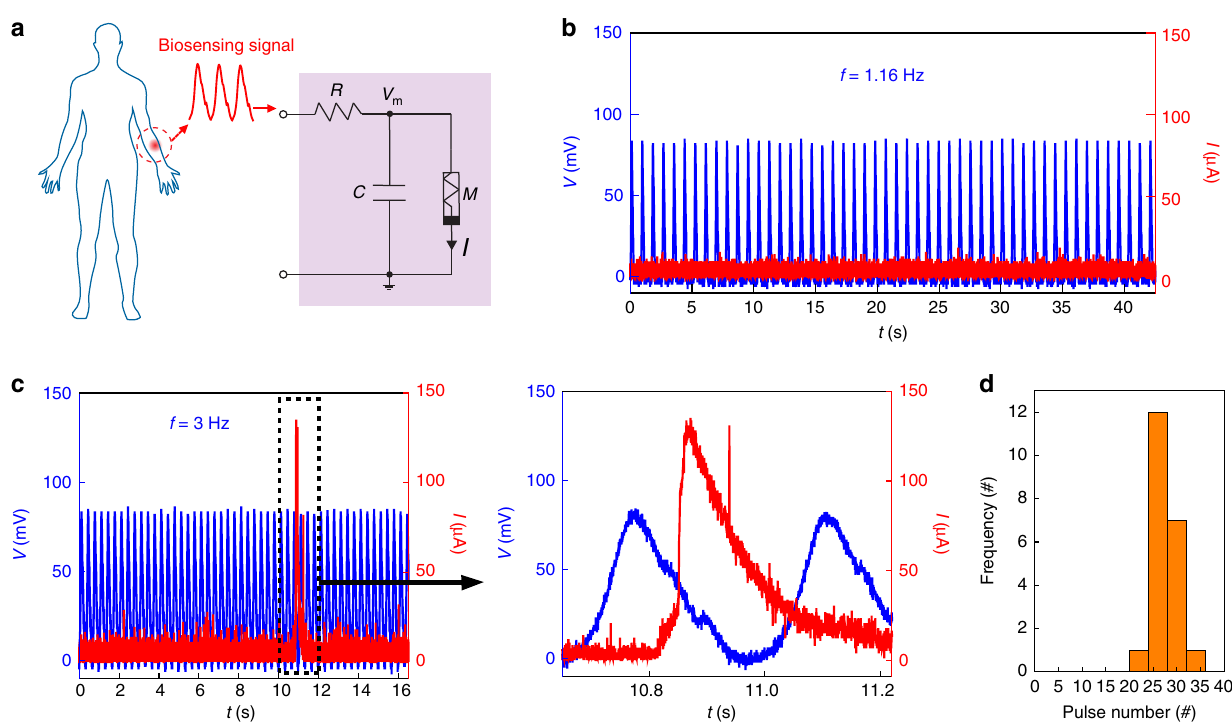
Fig. 6 Bio-signal processing. a Circuit of an arti fi cial neuron constructed using bio-voltage memristor ( M ). A parallel capacitor C = 100 μ F and series resistor R = 10 k Ω were used to yield a time constant ( RC = 1 s). Emulated biosensing signals (e.g., pulse) were input to the neuron. b Pulse (blue) frequency of normal heart rate (1.16 Hz) could not trigger the neuronal fi ring (red). c Left panel, pulse (blue) frequency of abnormal heart rate (3 Hz) triggered the neuronal fi ring (red peak). Right panel, zoom-in pulse signal (blue) with dicrotic feature and triggered neuronal fi ring (red) featuring a fast depolarization and relatively slow repolarization similar to an action potential 52 . d Statistics of pulse number (26.3 ± 16.4, ±s.d.) needed to trigger neuronal fi ring at f = 3